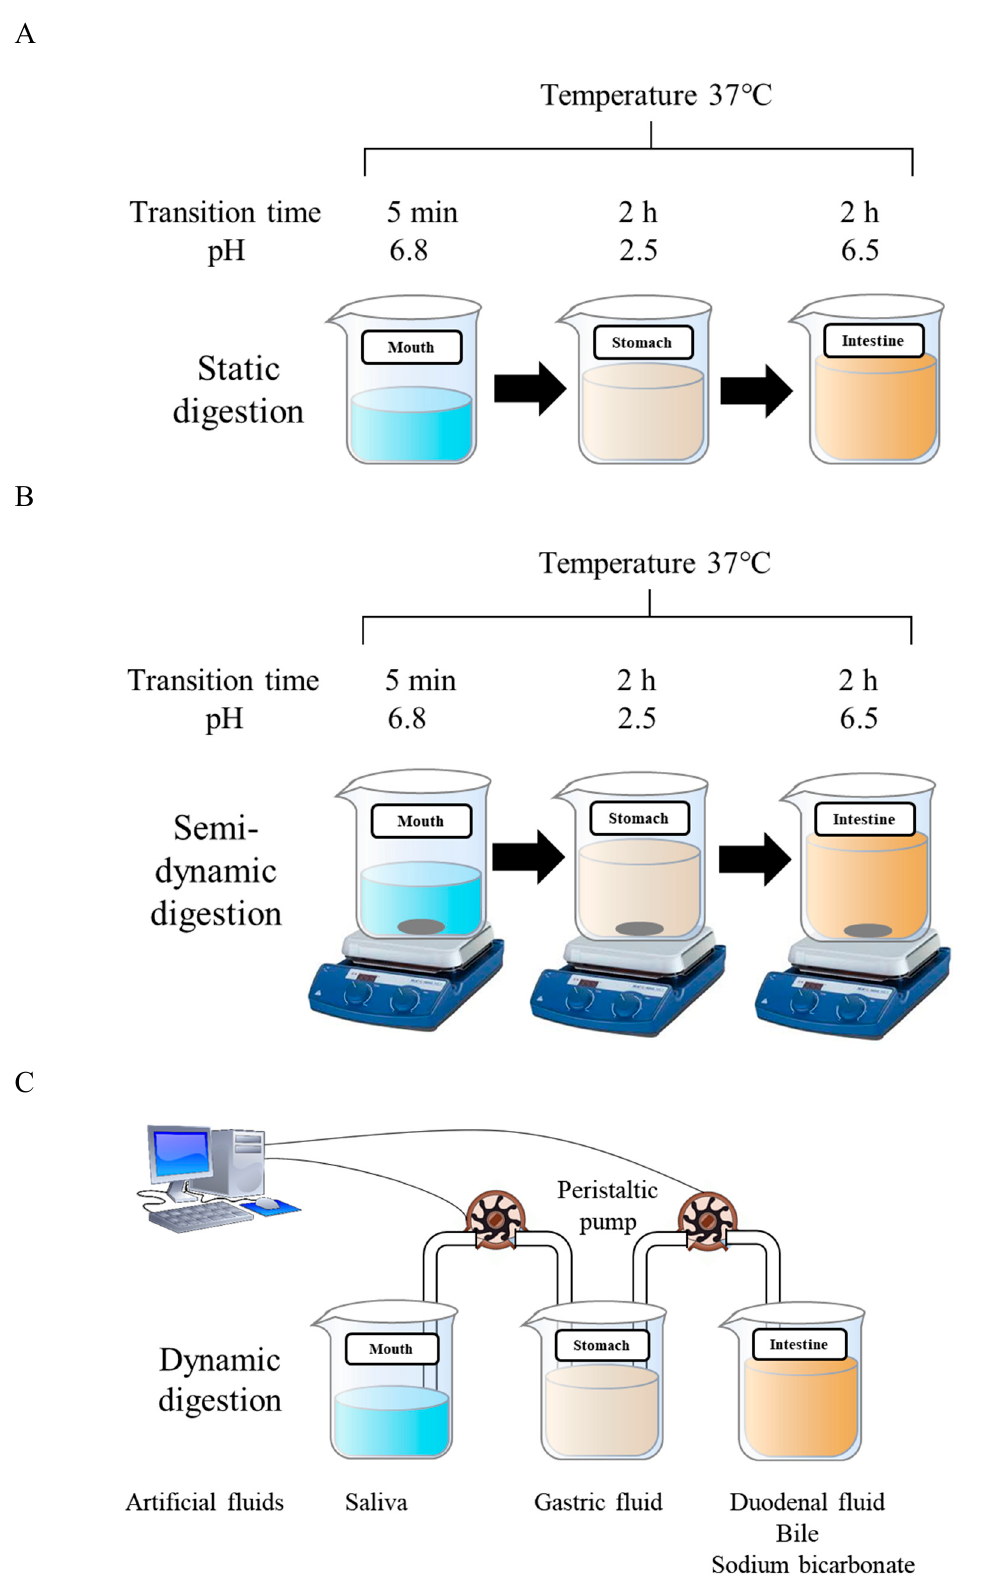
Figure 4. Static digestion ( A ), semi-dynamic digestion ( B ), and dynamic digestion ( C ) models of DHA delivery systems.